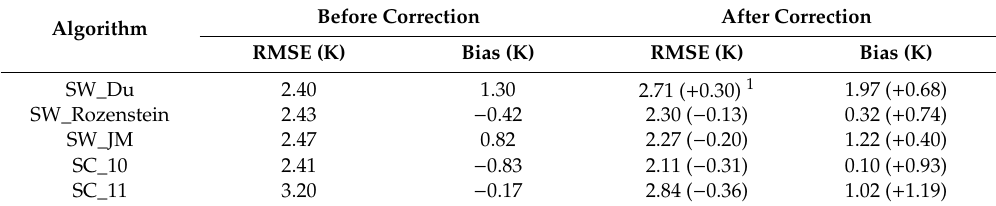
Table 5. The RMSE and bias of Landsat 8 LST retrieval from five algorithms before and after the stray light correction over all sites excluding